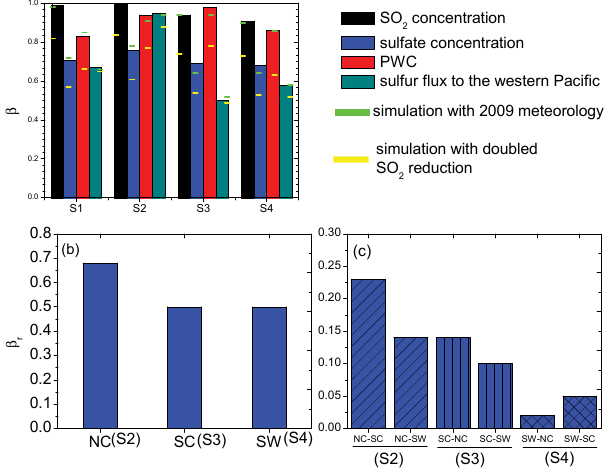
Figure 6. (a) Emission control efficiency factors ( β ) of national mean SO 2 and sulfate concentrations, population-weighted sulfate concentrations (PWC), and sulfur fluxes from China to the western Pacific in S1–S4 simulation scenarios. (b) Regional efficiency fac- tors ( β r ) of sulfate concentrations over NC, SC, and SWC to within- region SO 2 emission changes. (c) Inter-regional efficiency factor by scenario. The efficiency factor of national mean sulfate concentra- tions, PWC, and eastward sulfur transport fluxes in the robustness sensitivity tests are presented in (a) ; the short green line represents results from simulation with meteorology for 2009, and the short yellow line represents results from doubled magnitude of SO 2 emis- sion reduction